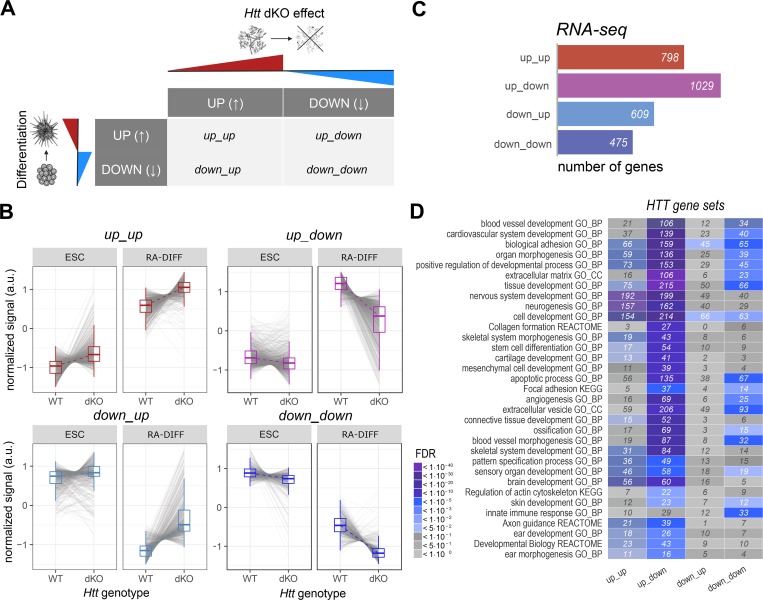
Classes of genes implicated in organ development whose expression was altered by Httex4/5 null mutation.A) Schematic describing the criteria applied to define the 4 classes of genes sensitive to both Hdhex4/5 null mutation and RA-induced differentiation. Up_up: genes up-regulated during differentiation and up-regulated by the Htt-null mutation; up_down: genes up-regulated during differentiation but down-regulated by Htt-null mutation; down_down: genes down-regulated during differentiation and further down-regulated by Htt-null mutation; down_up: genes down-regulated during differentiation, but upregulated in the context of Htt-null mutation. B) Expression trajectory plots describing variations in transcriptional levels across the two Htt genotypes (WT and dKO) and two developmental stages (ESC and RA-DIFF) of the genes belonging to the 4 categories described in A). a.u., arbitrary units. C) Bar blots displaying the number of genes (from RNA-seq analysis) for each of the 4 categories (up_up, up_down, down_down, down_up as described in A). Most of the genes were found in the up_up and up_down groupings. D) Enrichment analysis of genes belonging to the 4 categories (Up_up; up_down; down_up; down_down, as described in A), highlighting the most enriched GO-terms [BP, Biological Process; CC, Cellular Component; MF; Molecular Function; KEGGs pathways and Reactome pathways]. Significance of enrichment is based on FDR values [color code as in the legend].